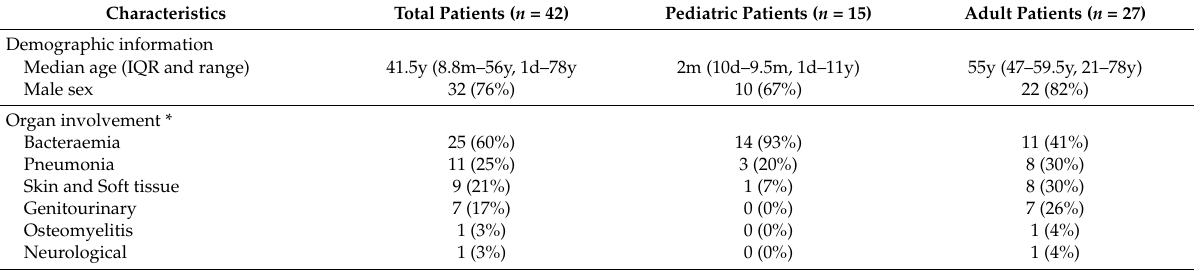
Table 3. Demographic data, clinical presentations, risk factors and outcomes of 42 culture-confirmed melioidosis cases with available clinical data from 2012 to